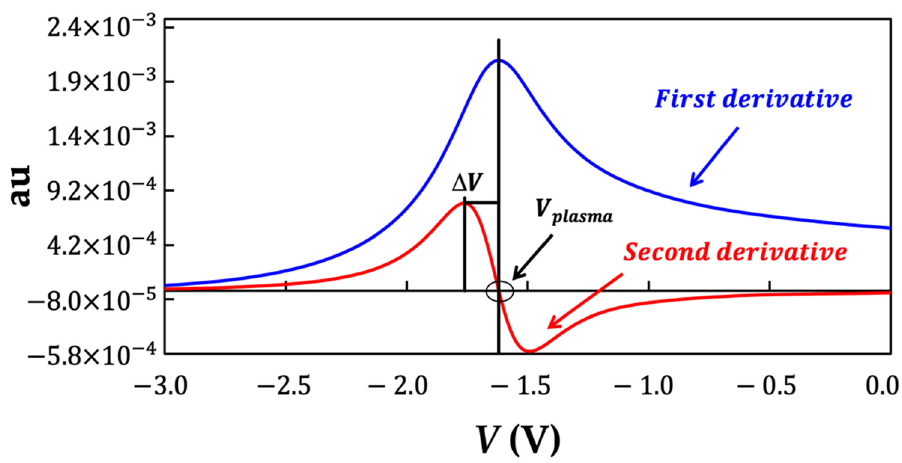
Figure 10. First and second derivative of the smoothed experimental IVCP from Figure 4.